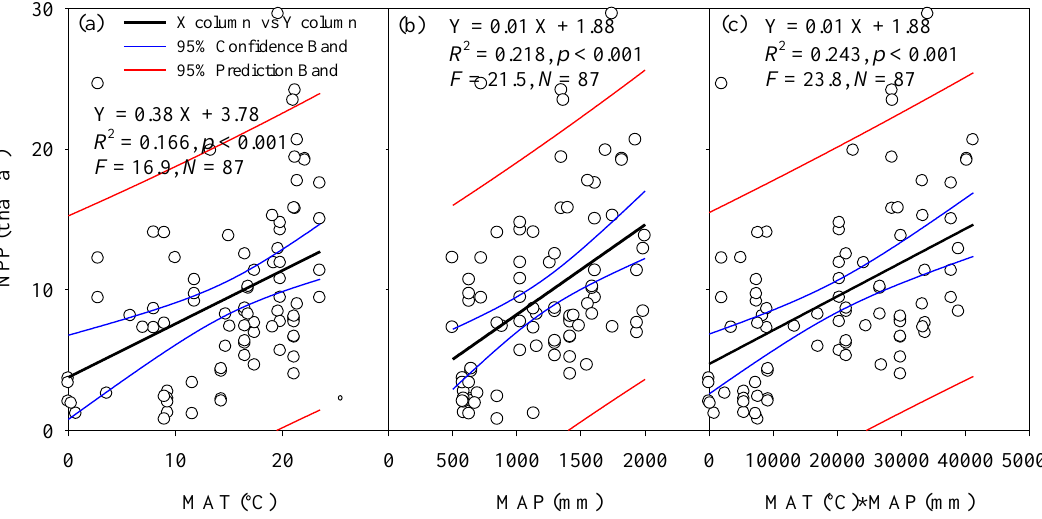
Figure 3. Relationships between net primary productivity (NPP) and mean annual temperature (MAT), mean annual precipitation (MAP), and combinations of MAT and MAP. N, number of observations; F, F Values. Table 2. Bivariate and multivariate regression models of net primary productivity (NPP) on climatic factors and soil N. MAP, mean annual precipitation; MAT, mean annual temperature; N soil , soil N content; N re , annual litter N; N, number of observations; F , F Values; RMSE, root mean square